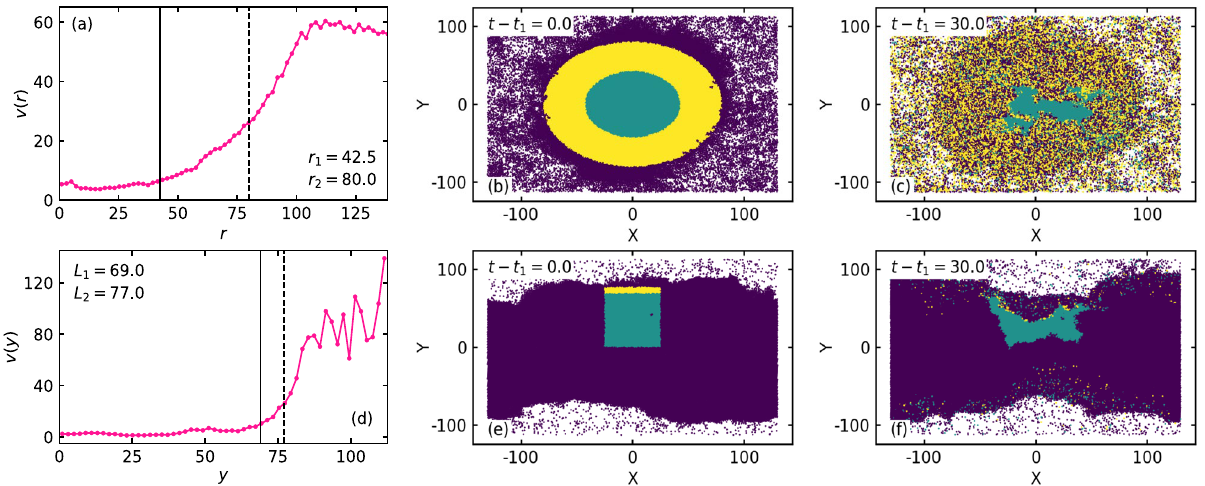
1 / 2 v ( v i Figure 5. Local speed v as a function of distance from the center of the high density phase for i ) = � · � 7 and ( d ) κ 17 , corresponding to the configuration in Fig. 3b,e, respectively. The configuration of the ( a ) κ = = 7 and ( e ) κ 17 . At t t 1 for ( b ) κ t 1 , the disks in the central region system at an arbitrary initial time t = = = = are colored green and that in the peripheral region are colored yellow. The other disks are colored purple. ( c , f ) 30 . t 1 Configurations at a later time t = +